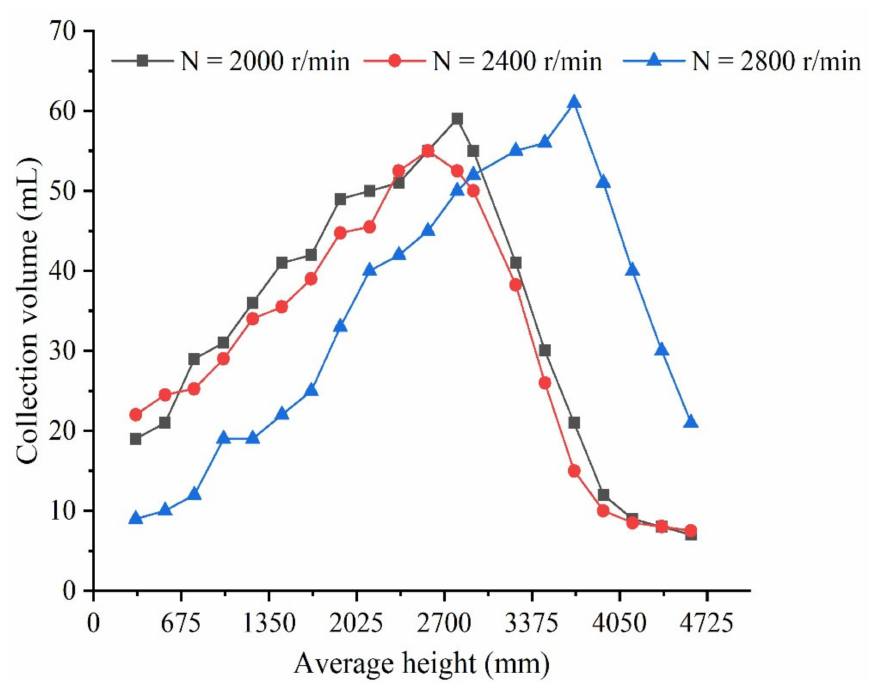
Figure 2. Influence of blower speed on the collection volume (W = 45 ◦ , L = 1.0 m).